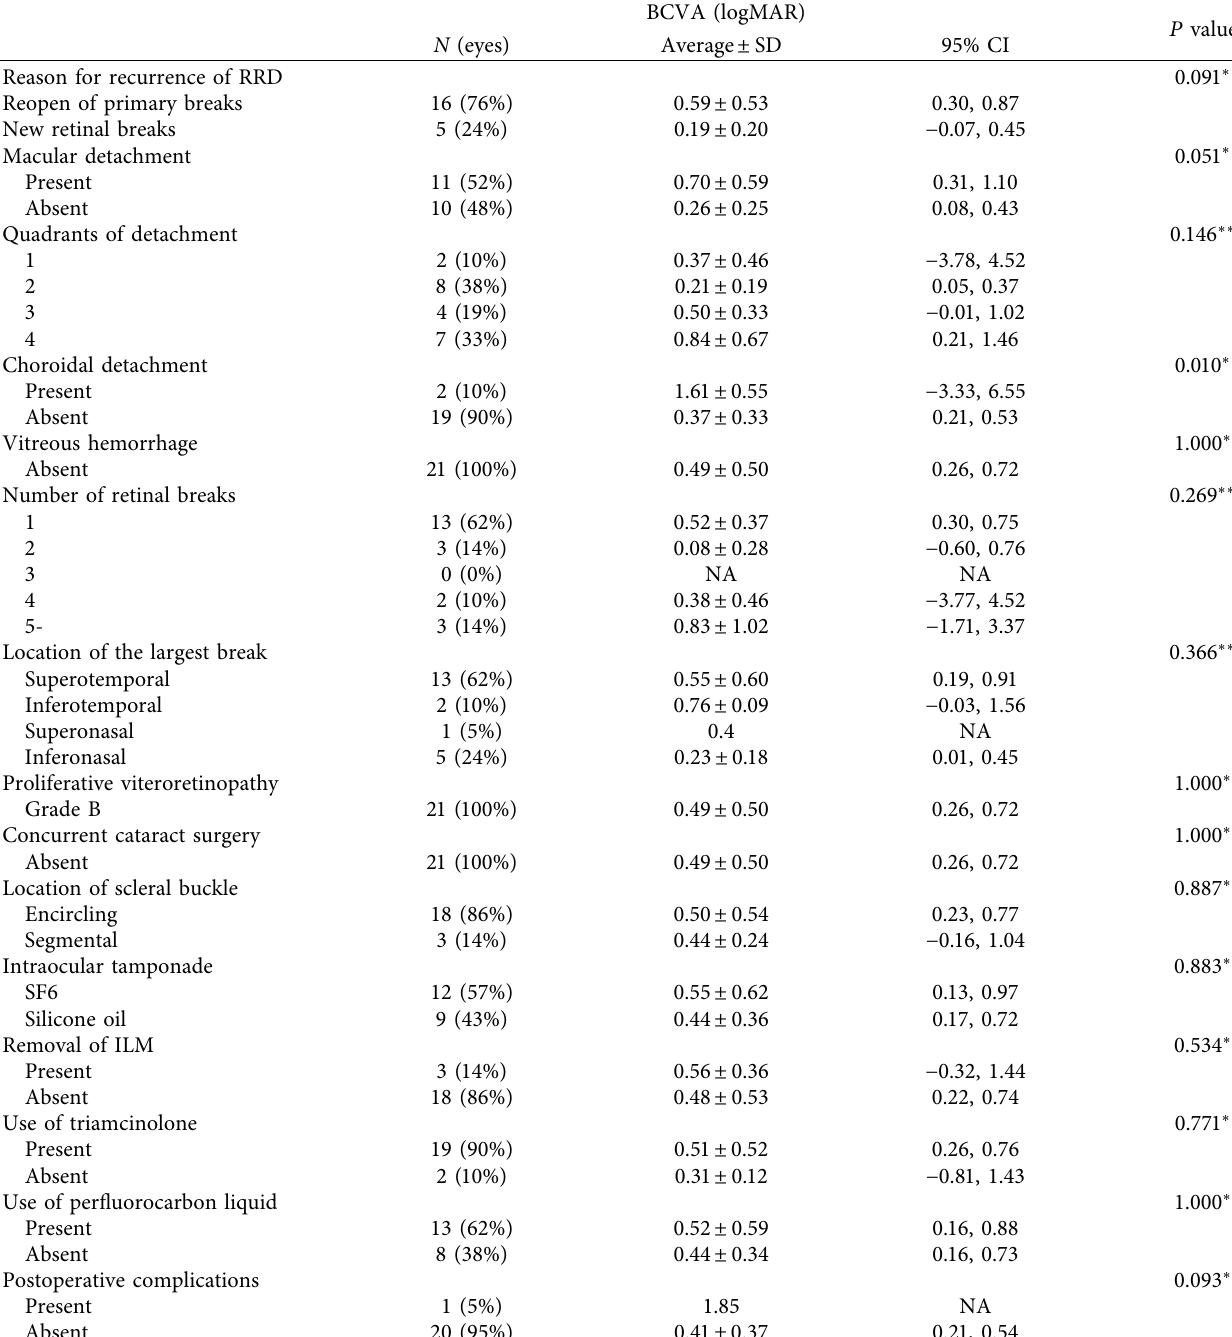
Table 2: Relationship between factors before surgery for recurrent retinal detachment and the final visual acuity. BCVA